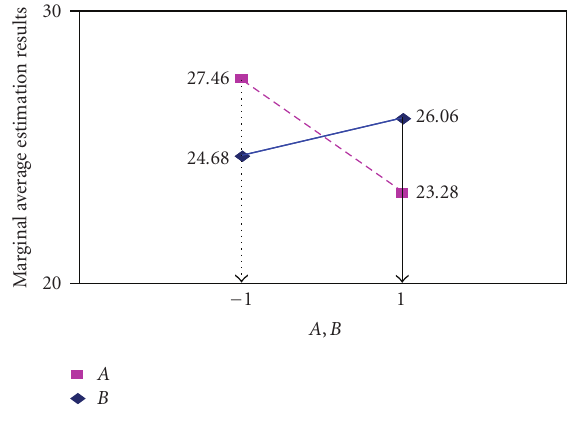
Figure 3: Interaction AB (Cys,